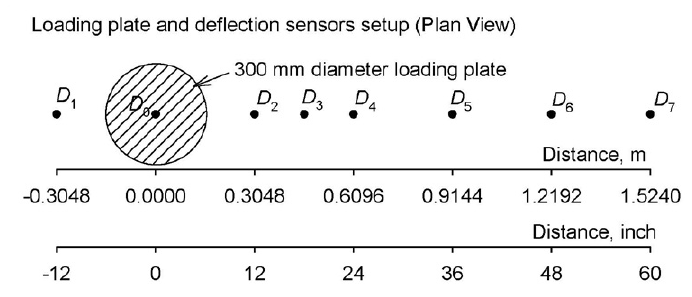
Figure 2. In situ testing equipment used in this